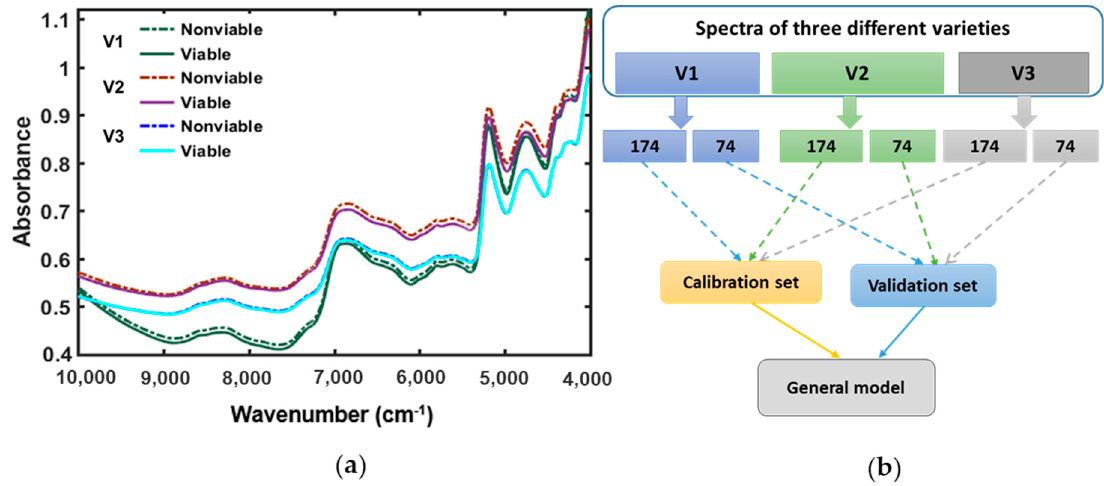
Figure 3. ( a ) FT-NIR spectra collected form three varieties of triploid watermelon seed; ( b ) General model development and validation.